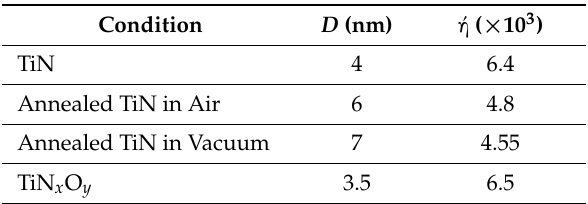
Table 3. Grain size and strain of as-deposited TiN, annealed TiN in air and in vacuum, and TiN x O y thin